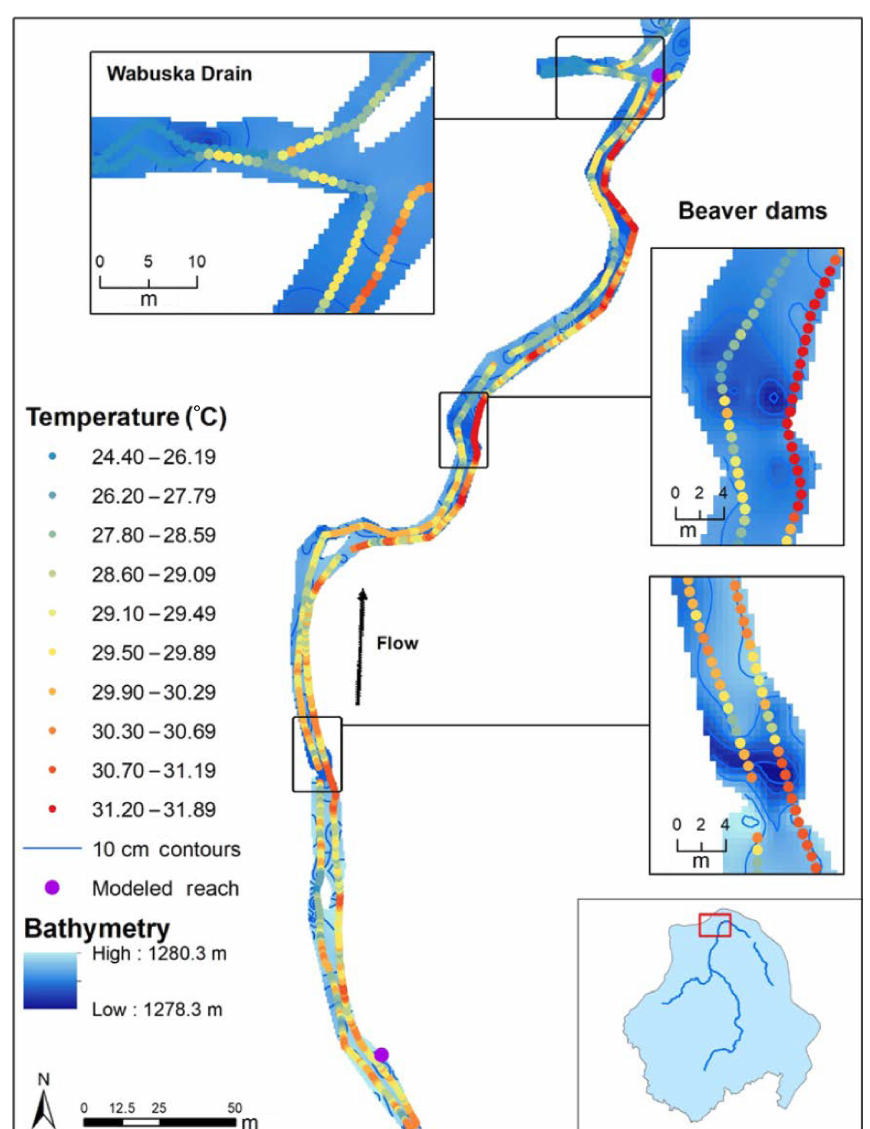
Figure 4. Main stem Walker River daily maximum stream temperature on 29 June 2015. Model reach points represent the division between 300m model